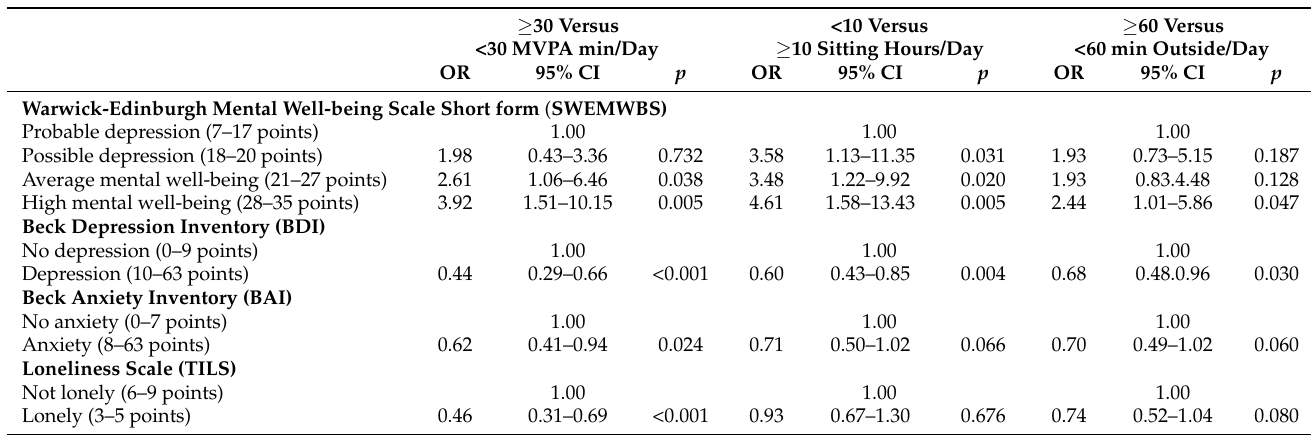
Table 4. Association between physical activity and psychological factors.